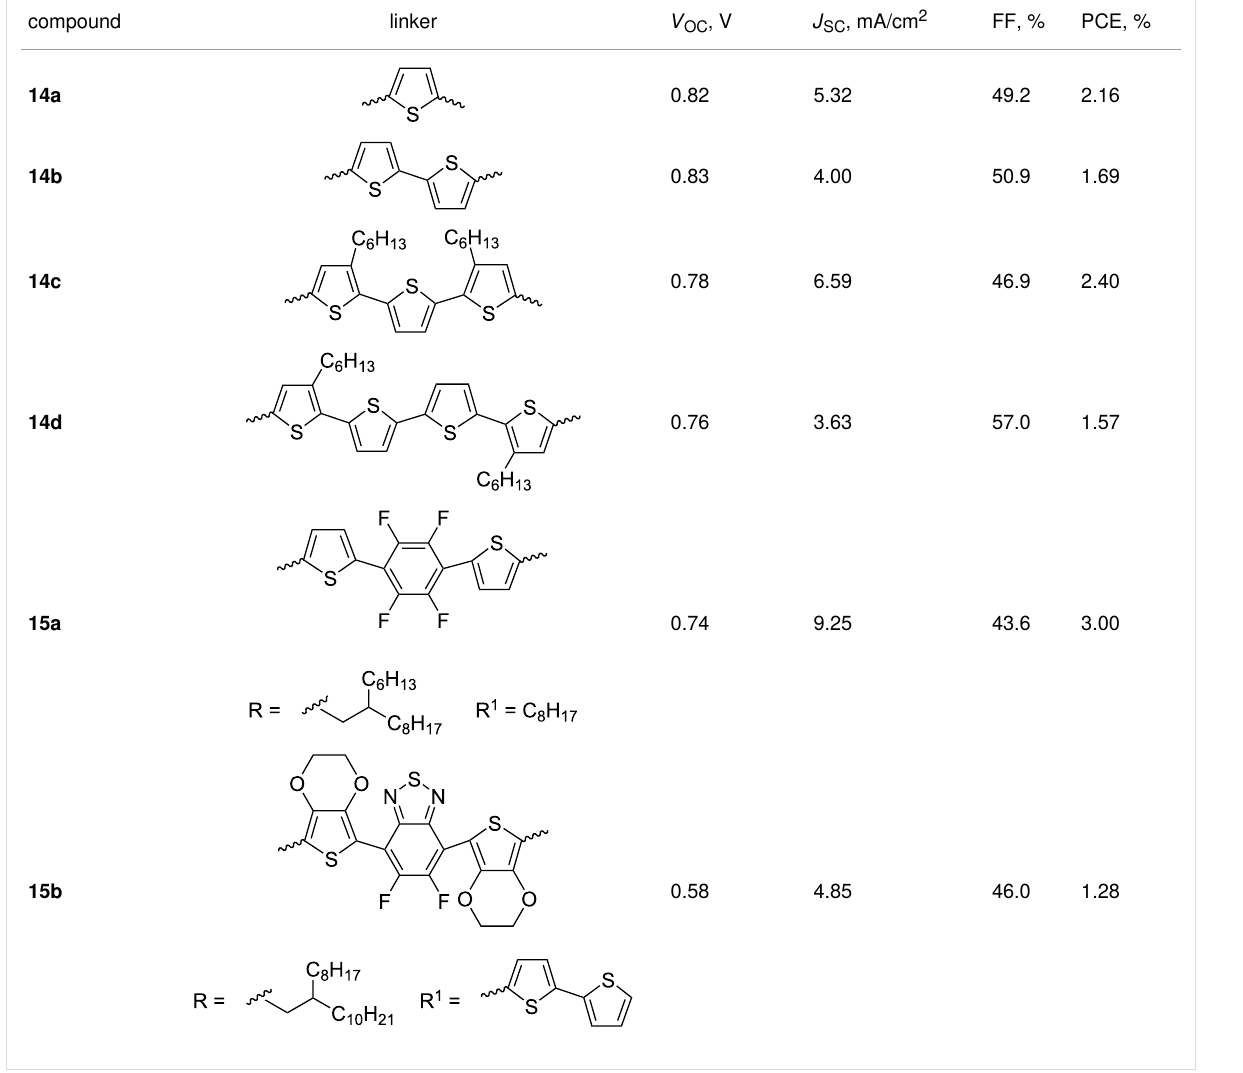
Table 2: Structures of linkers in bisisoindigos 14 and 15 and the performance of OSCs based on these.